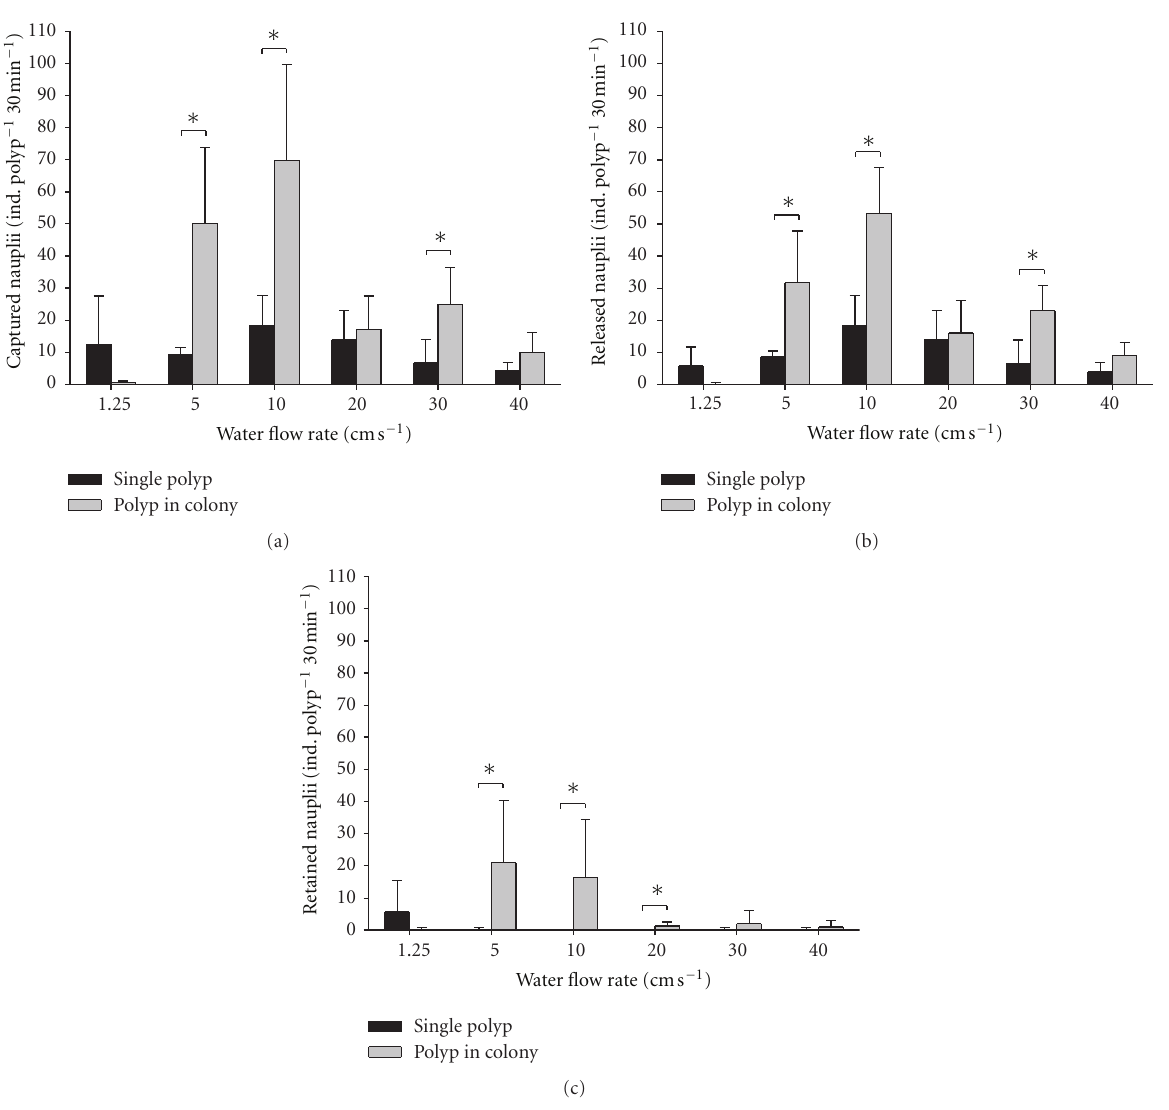
Figure 2: Prey capture (a), release (b), and retention (capture minus release, (c) rates of Galaxea fascicularis single polyps (black bars) and polyps in colonies (grey bars) at water flow rates of 1.25 to 40cm s − 1 . Values are means + sd ( n = 4). ∗ Indicates significant di ff erence ( P < 0 . 050, simple e ff ects analysis).